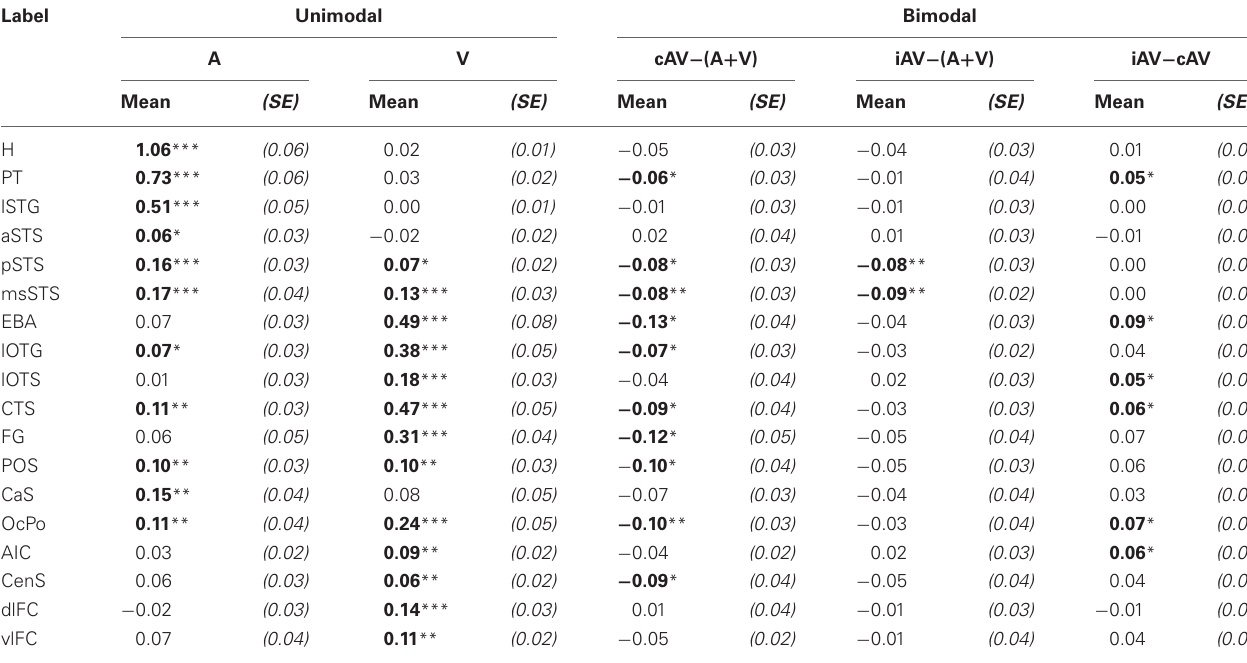
Table 1 | Mean BOLD responses per